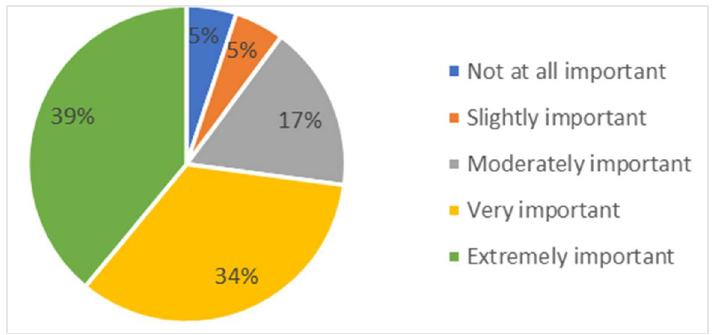
Figure 4. Opinion of respondents on how important they think it is to consider carbon sequestra- tion strategies in building design.